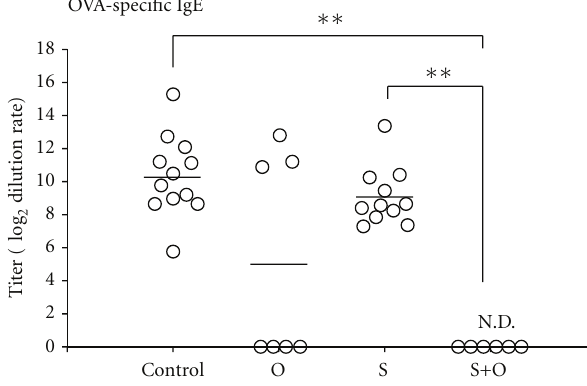
Figure 3: E ff ects of the maternal exposure to food antigens during lactation and the maternal allergic status on plasma IgE levels of o ff spring in the mouse FA model. Plasma IgE levels were undetectable in o ff spring breastfed by OVA-sensitized and OVA- exposed lactating mothers. Data are shown as the means and individual data points. N.D.: not detectable. ∗∗ P < 0 . 01, n = 6–11.